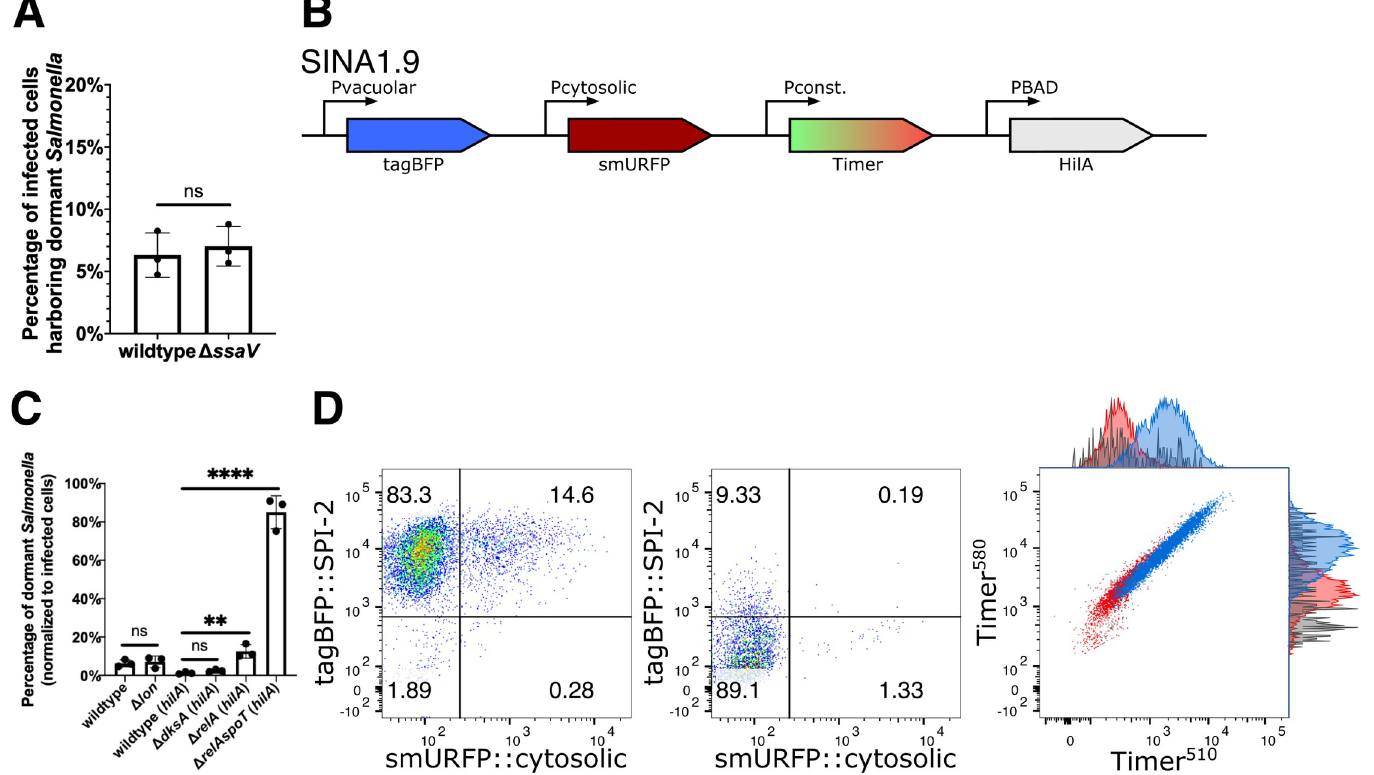
Fig 3. S . Typhimurium dormancy is negatively regulated by SpoT. (A) HeLa cells were infected with SINA1.1-harboring S . Typhimurium, the abundance of Vac - Cyt - population in wild type and SPI-2 mutant Δ ssaV infected cells were quantified with flow cytometry at 6 h pi. (n = 3) (B) Schematic diagram for the construction of SINA derivative, SINA1.9, yielded from the introduction of an arabinose-inducible hilA expression cassette into SINA1.1. SINA1.9 was used to rescue the reduced invasiveness of Δ dksA , Δ relA and Δ relAspoT mutant strains. (C) HeLa cells were infected with SINA1.1 or SINA1.9-harboring S . Typhimurium, the abundance of Vac - Cyt - population in (p)ppGpp biogenesis and regulon mutants, Δ lon , Δ dksA , Δ relA and Δ relAspoT were quantified by flow cytometry at 6 h pi (n = 3) (D) Distribution of Vac - Cyt - , Vac + Cyt - and Vac + Cyt + populations in hilA -expressing wild type (Left) and Δ relAspoT mutant (Middle) infected HeLa cells at 6 h pi quantified by flow cytometry. Overlay Timer bac profile (Right) of Vac - Cyt - (red) and Vac + Cyt - (blue) populations of wild type and Vac - Cyt - population of Δ relAspoT mutant (grey) in infected HeLa cells quantified by flow cytometry at 6 h pi. (3 independent experiments) At least a total of 1000 events of infected cells were analyzed by flow cytometry in triplicate experiments. Statistics were performed using unpaired t test. ns: not significant ( P > 0.05), �� P < 0.01, ���� P <